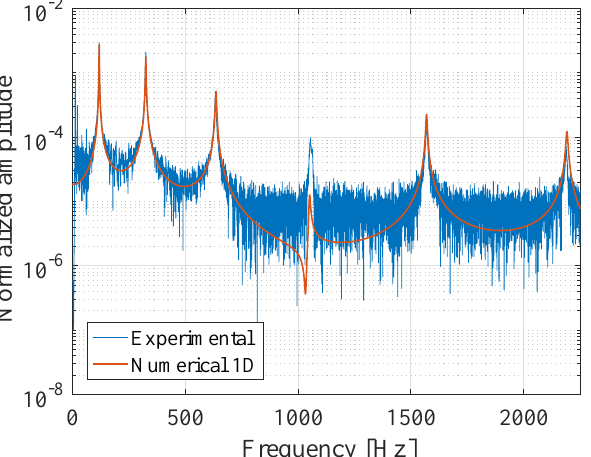
Figure 13. Comparison of Fourier transform of numerical and experimental signals for neutral axis point of the clamped–clamped beam at abscissa x = 14.10 cm.